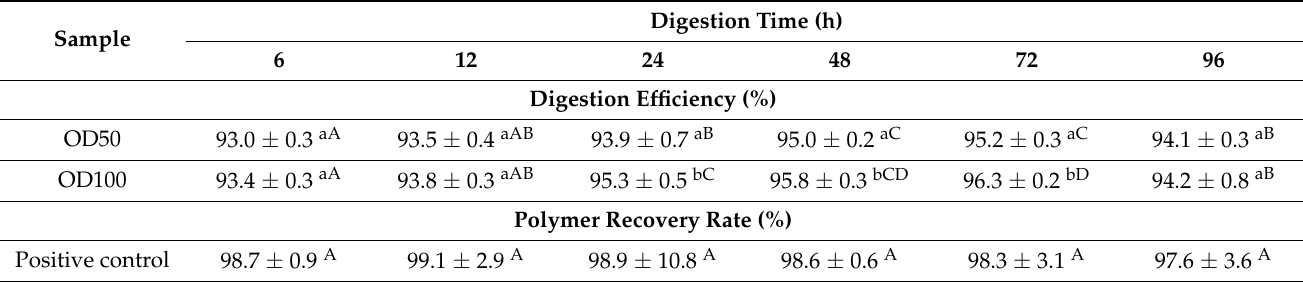
Table 2. Digestion efficiency and polymer recovery rate observed for oxidative digestion of G. fisheri .